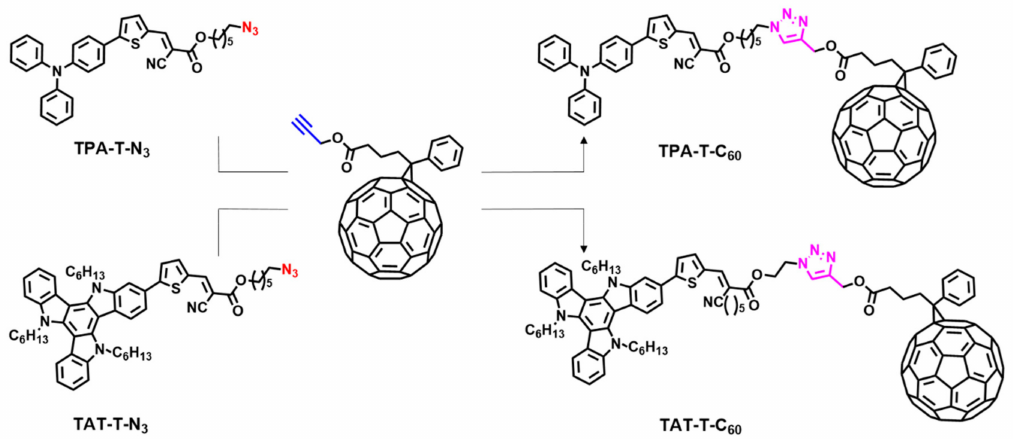
Figure 1. Illustration of our early reported molecular dyads and strategies.